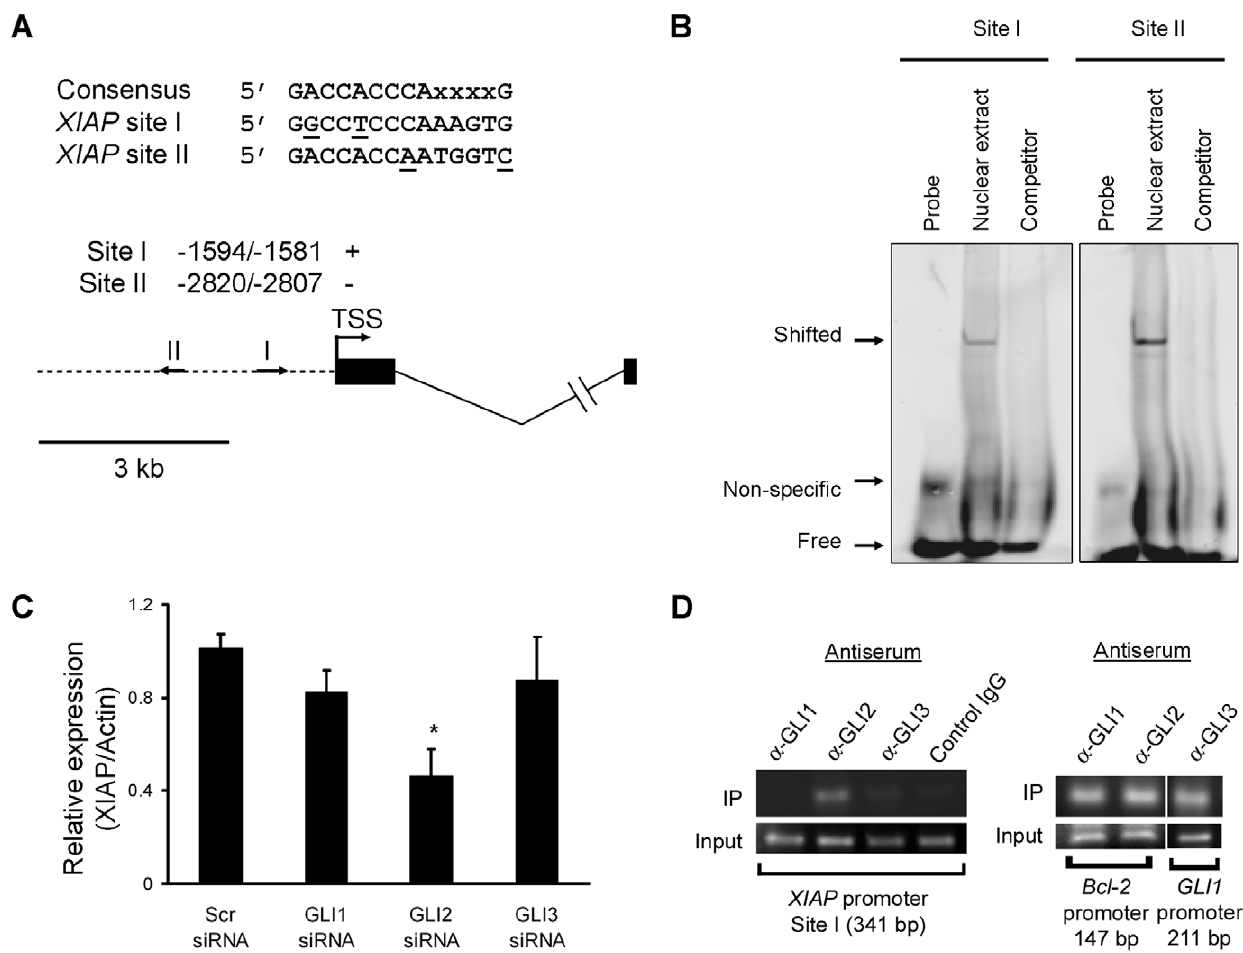
Figure 2. XIAP promoter predicted GLI-binding sites exhibit sequence-specific binding to nuclear proteins. A, Putative GLI binding sites in theXIAP promoter region. Nucleotide positionswere counted from the transcriptionstart site (TSS). Potential binding siteswere observedasindicated by arrows on the schematic (I and II). B, Nuclear protein extracts were isolated from KMCH cells. EMSA was performed using Cy5.5-labeled double- stranded oligonucleotides containing the putative GLI binding sequences within the human XIAP promoter, and competition experiments with 200-fold molar excess cold oligonucleotides as described under ‘‘MATERIALS AND METHODS’’. C , Total cellular protein was isolated 48 hours after transient transfection with the indicated siRNA against GLI family members. XIAP protein expression was determined by immunoblotting and the signal was quantified by densitometry as a ratio to actin expression. D, Chromatin immunoprecipitation using antiserum to GLI1, GLI2, GLI3, or a control IgG was performed followed by PCR using primers flanking site I (341 bp) within the XIAP promoter region, as indicated. As a positive control, ChIP was performed using primers flanking the Bcl-2 promoter GLI-binding site (GLI1 and GLI2), or primers flanking the GLI3 bindingsite within the GLI1 promoter.